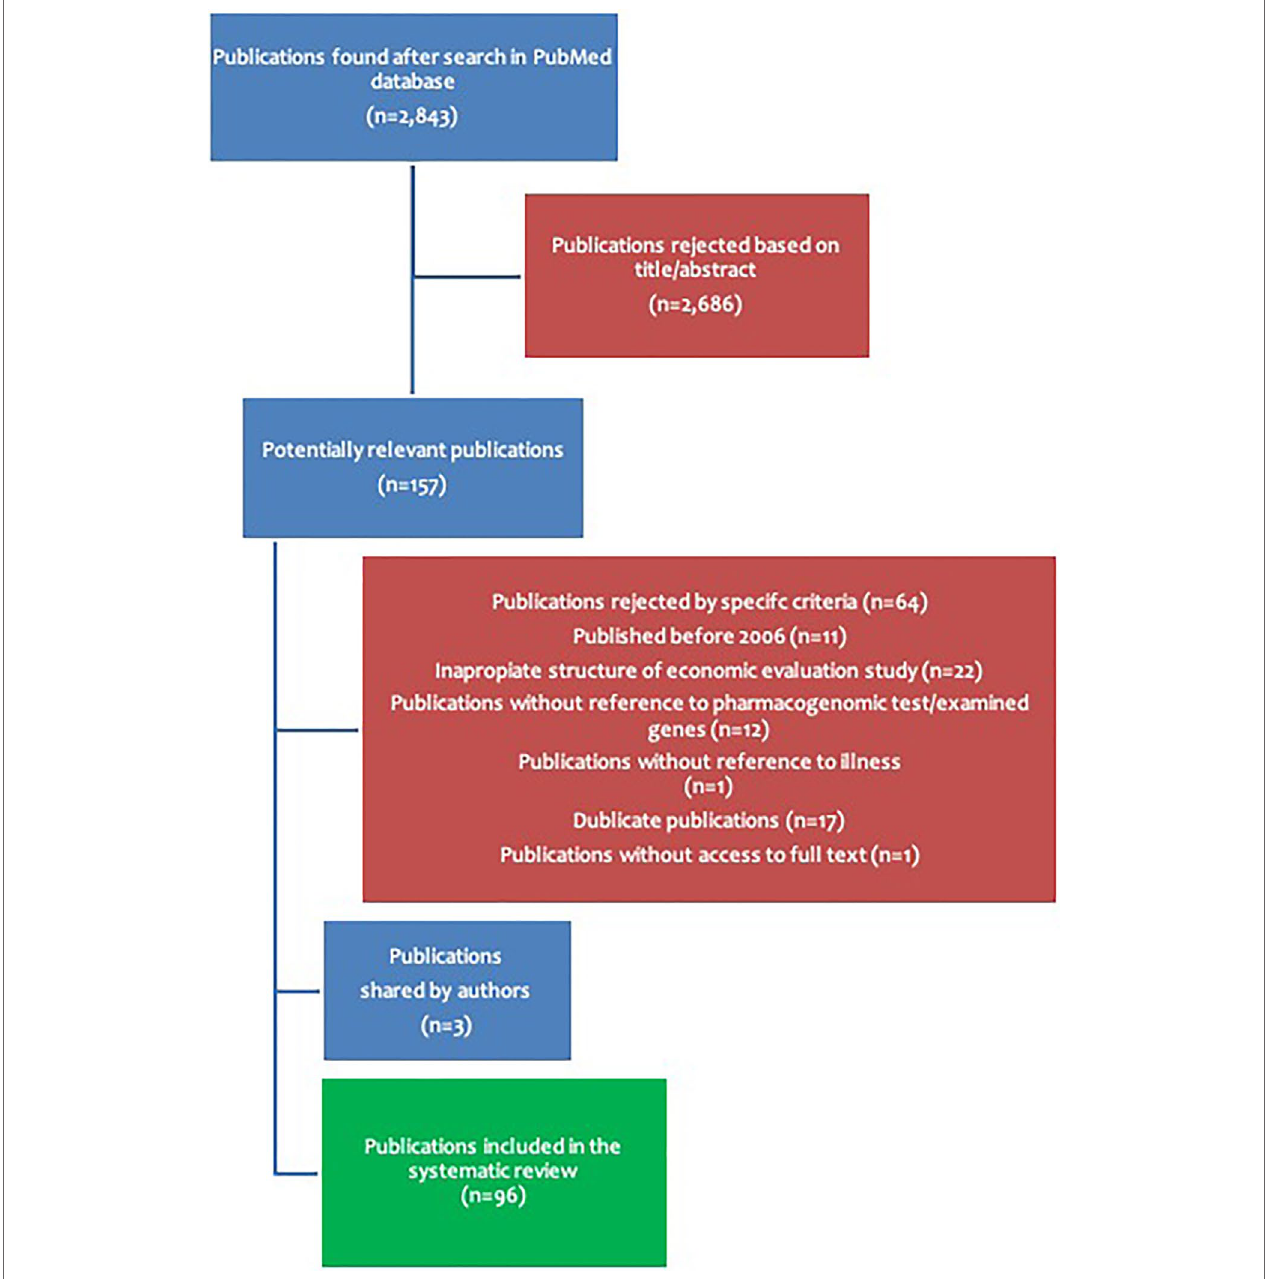
FIGURE 1 | Overview of the article querying methodology in the PubMed literature